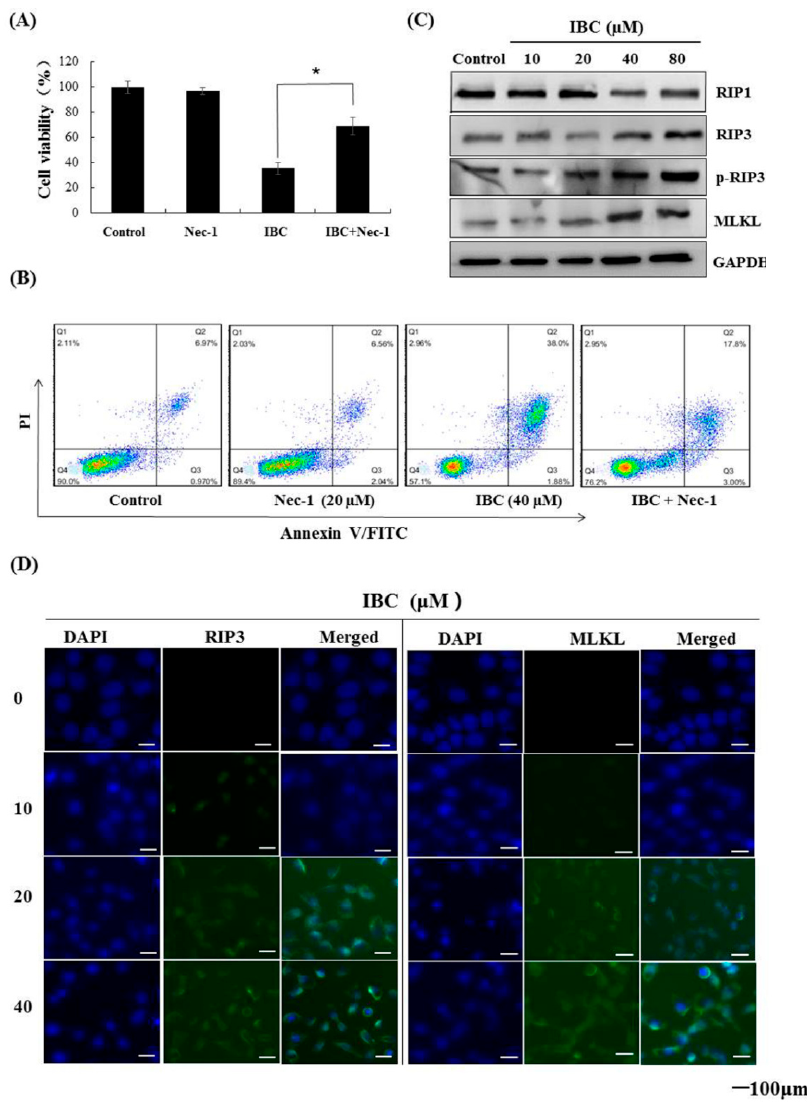
Figure 6. IBC induced necroptosis in human triple-negative breast MDA-MB-231 cancer cells. ( A ) Cell viability following treatment with IBC (40 µ M) for 24 h alone or with the necroptosis inhibitor Nec-1 (20 µ M) pre-treatment as measured by the MTT assay. ( B ) Annexin V-FITC/PI analysis following treatment with IBC with or without pre-treatment with Nec-1. ( C ) Western blotting analysis of necroptosis-related proteins (RIP1, RIP3, p-RIP3, and MLKL). ( D ) The cells were treated with IBC and incubated overnight with the primary antibodies at 4°C. The localization of RIP3 and MLKL was assessed by immunofluorescence staining. Nuclei were stained with DAPI. * p < 0.05 compared between the groups of IBC and IBC with Nec-1.